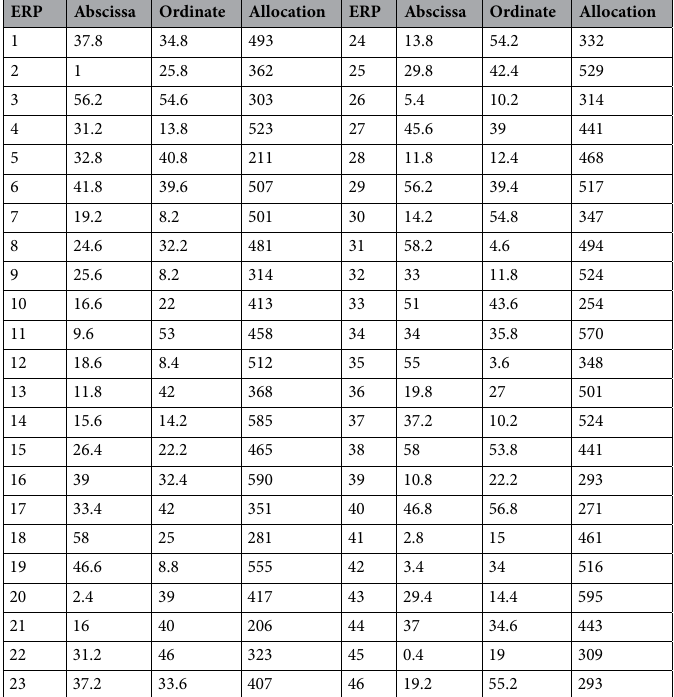
Table 1. ERP coordinates and distribution of medical materials.